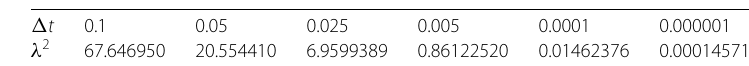
Table 7 β ∼ Exponential(0.5), α = 1 and (cid:4) x =